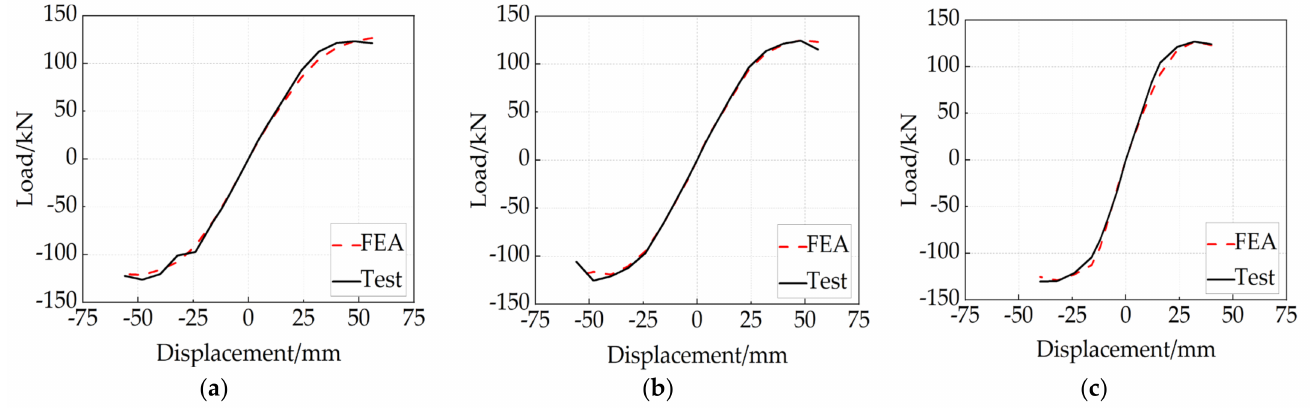
Figure 20. Comparison of envelope curves between test and FEA results: ( a ) Specimen S–CFT–A;